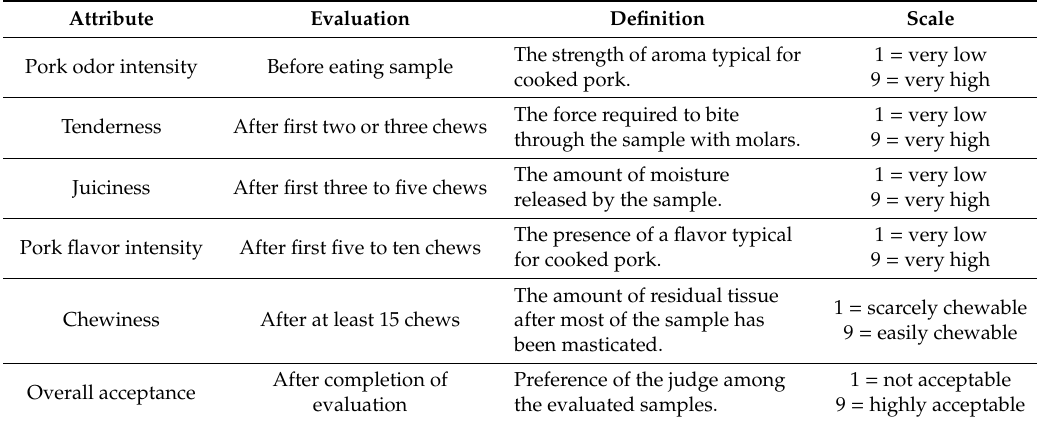
Table 3. Definition and scale of attributes used in the meat sensory